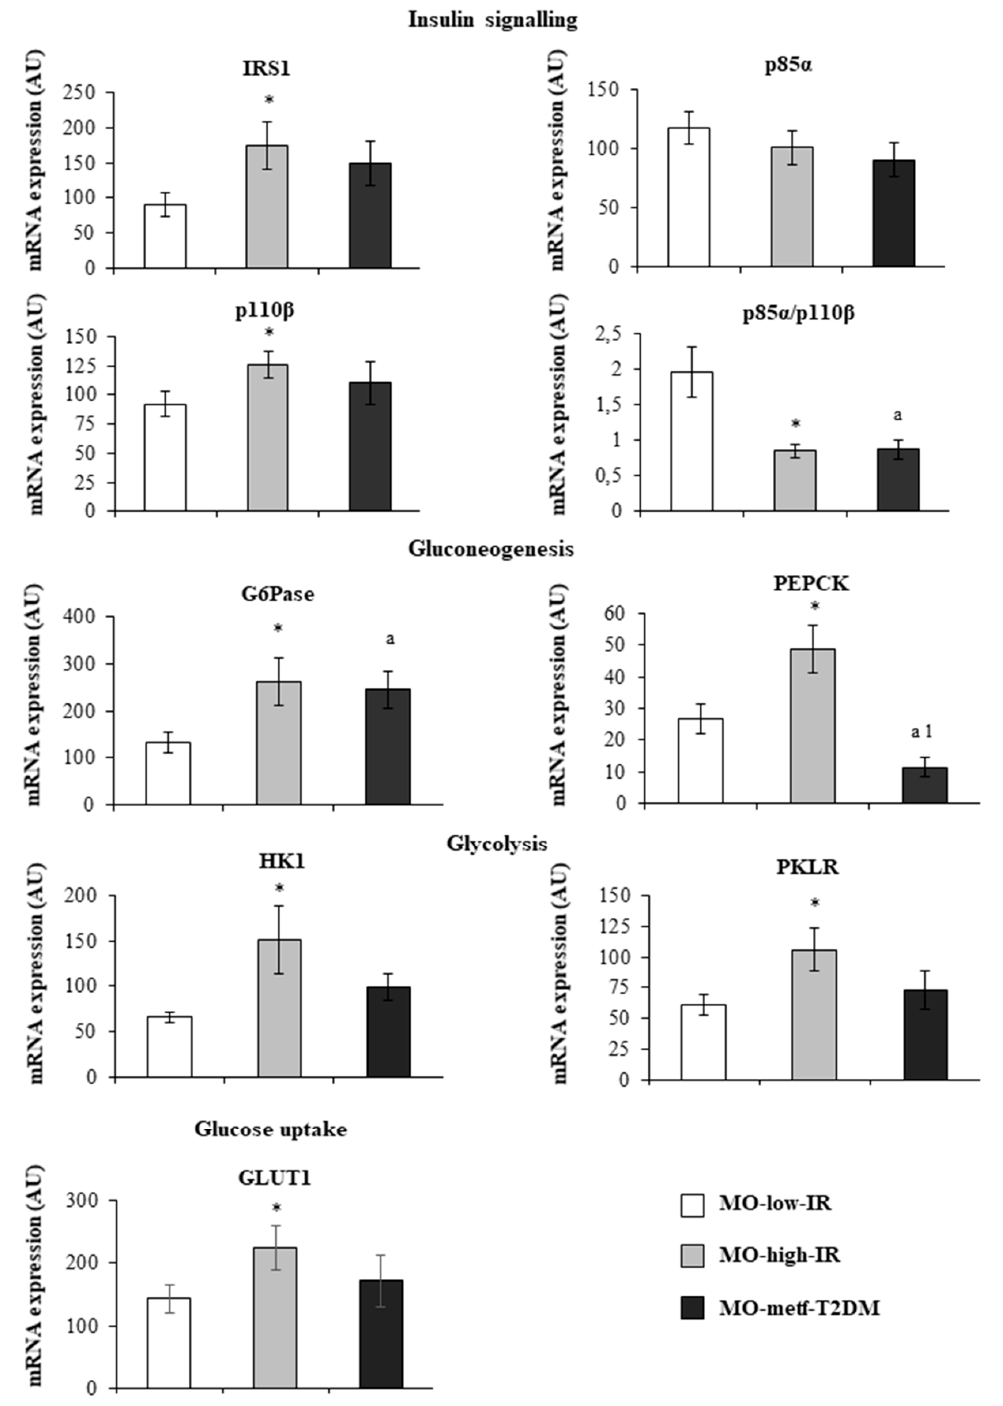
Figure 1. mRNA expression levels of studied genes in the jejunum of MO-low-IR ( n = 15), MO-high-IR ( n = 15) and in MO-metf-T2DM ( n = 15). The results are given as mean ± SEM (standard error of the mean). * p < 0.05: significant differences with regard to MO-low-IR group. a p < 0.05: significant differences between MO-high-IR and MO-metf-T2DM groups. IRS1: insulin receptor substrate 1. p85 α : phosphatidylinositol 3-kinase 85 kDa regulatory subunit alpha. p110 β : phosphatidylinositol 3-kinase 110 kDa catalytic subunit beta. G6Pase: glucose-6 phosphatase. HK1: hexokinase 1. PKLR: L-type pyruvate kinase. GLUT1: solute carrier family 2 member 1 or glucose transporter 1. PEPCK: phosphoenolpyruvate carboxykinase. 1 p <